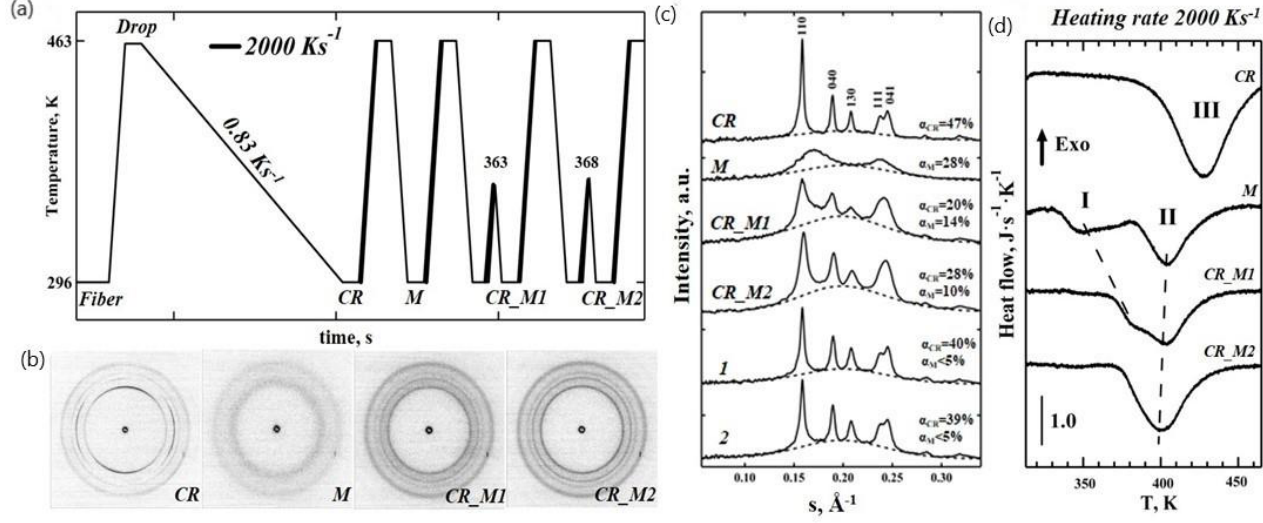
Figure 2. Mesophase–crystal phase transition in iPP. ( a ) Temperature–time (TT) profiles used to obtain different iPP morphologies; ( b ) two-dimensional WAXS patterns corresponding to the crystalline ( CR ), mesomorphic ( M ), and crystalline–mesomorphic ( CRM1, CRM2 ) states; ( c ) The 1D WAXS profiles of iPP (Y axis — intensity, a.u., X axis — the modulus of the scattering vector, Å −1 ). The polymer morphologies are indicated above each of the convoluted profiles and include crystalline ( CR ), mesomorphic ( M ), and crystalline–mesomorphic ( CR_M1, CR_M2, 1, 2 ) morphologies. Crystalline and mesophase fractions ( α CR , α M ) are specified for each of the morphologies. Dashed lines indicate a contribution of the amorphous fraction. Samples 1 and 2, shown here for comparison, were generated by heating the mesophase to 413 K using heating rates of 0.5 K s −1 and 2 K s −1 and then quenching the polymer to room temperature. ( d ) Heating endotherms with a constant rate of 2000 K s −1 probing the resulting iPP morphologies. All of the endotherms are normalized by the sample mass and heating rate.